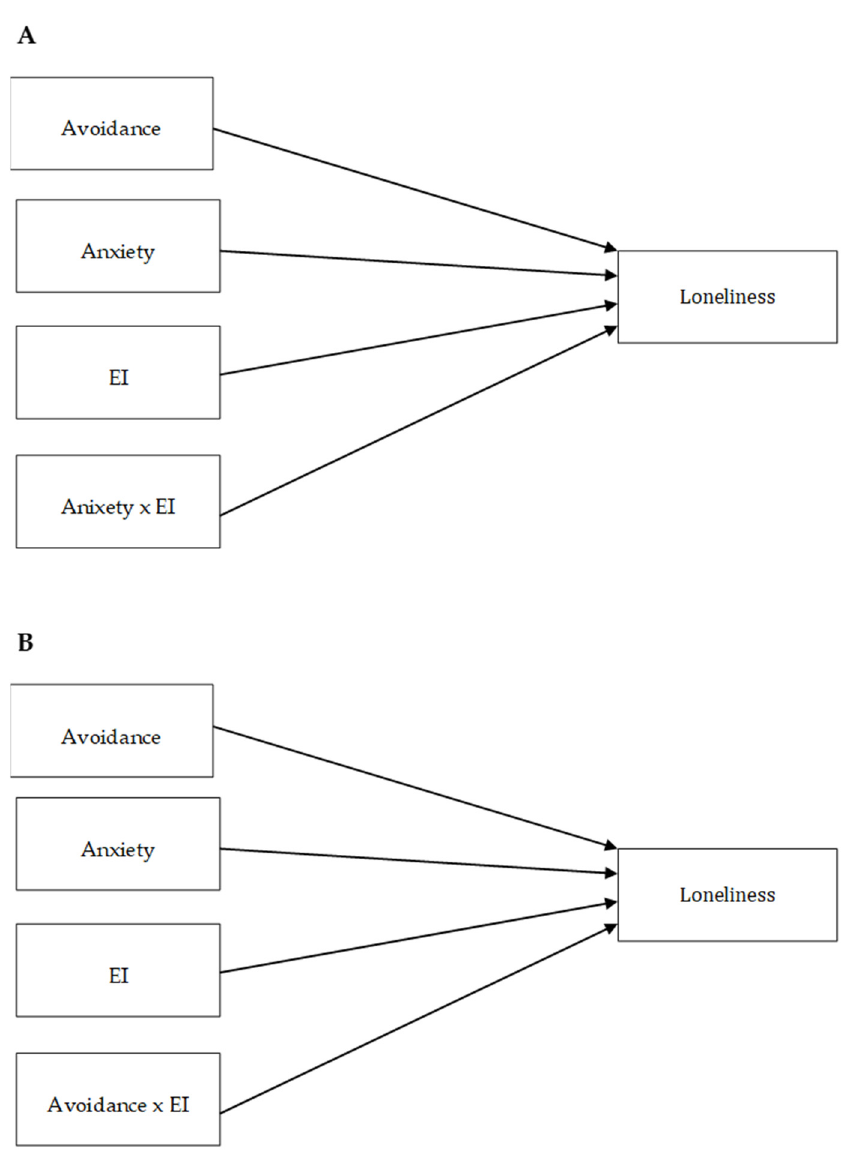
Figure 3. Moderation models for attachment anxiety ( A ) and attachment avoidance ( B ) tested in Studies 1 and 2.